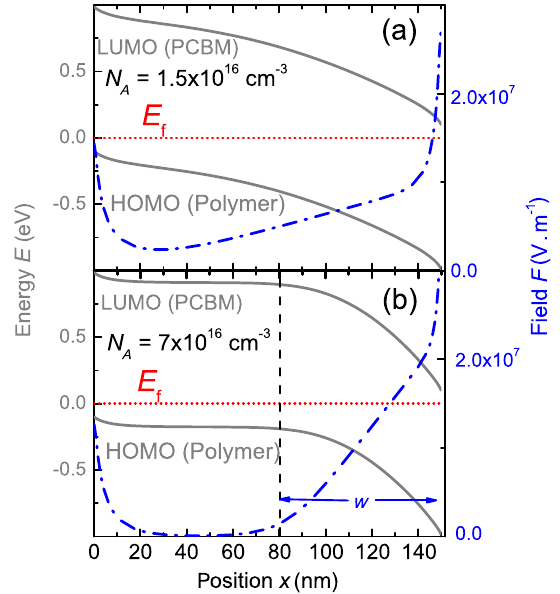
FIG. 1. Simulated band diagram obtained with advanced semiconductor analysis in the dark at short circuit for 150-nm- thick active-layer devices at two p -type doping levels: (a) 1 . 5 × 10 16 cm − 3 and (b) 7 × 10 16 cm − 3 . The devices are illuminated from the glass and ITO at position 0. Although the undoped device is still fully depleted at 150 nm, in the doped version, the strong electric field (dash-dotted lines) will develop only over a part of the total active-layer